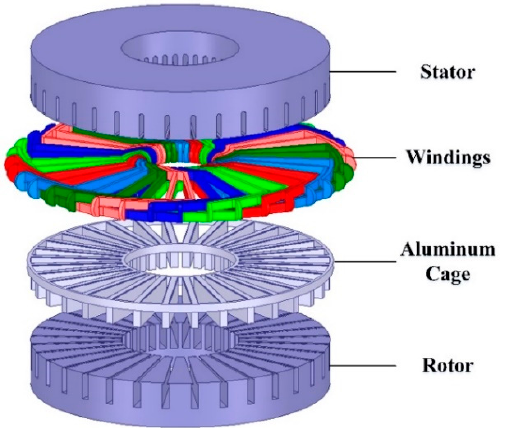
Figure 1. Single-sided Axial Flux Induction Motor (AFIM) components.